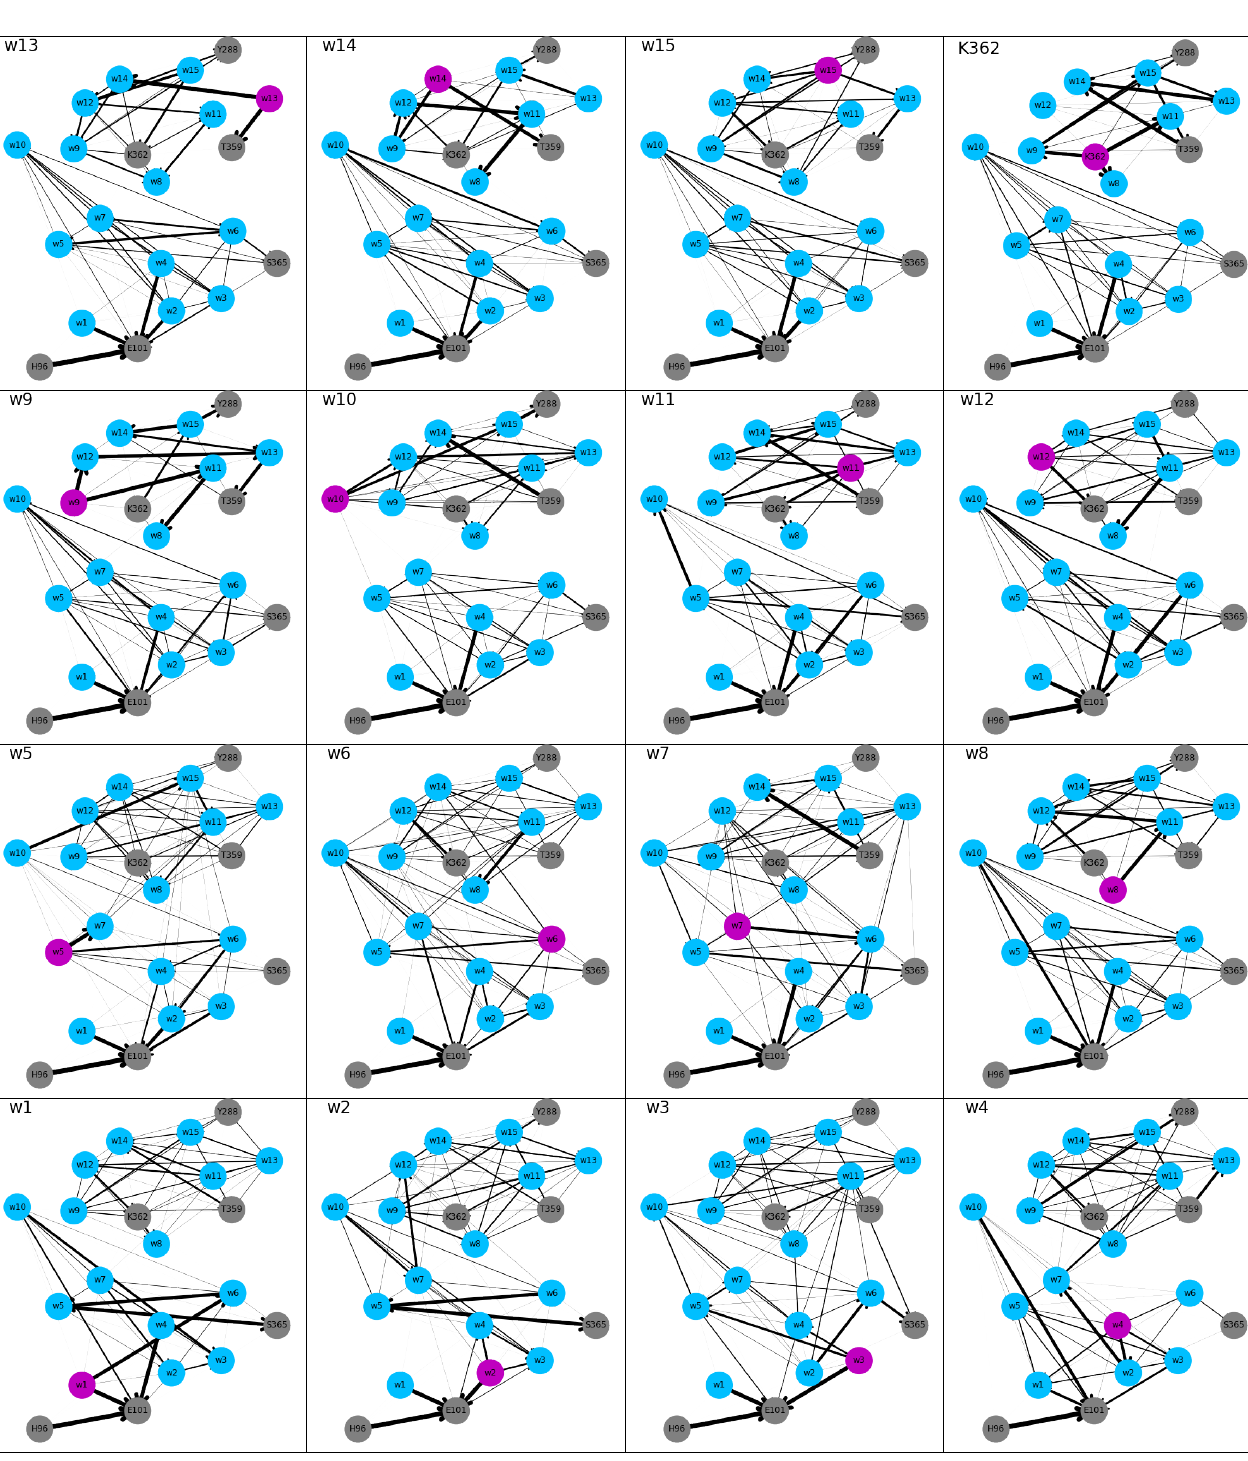
Figure 5. Directed hydrogen-bonded network computed from the MD simulations of “up” models with the excess proton located at different residues. The nodes of the network are the protein residues (in gray) Y288, T359, K362, S365, H96, or E101, and the fifteen water molecules (in blue) in the channel. The residue carrying the excess proton is highlighted in magenta. Edges of the network correspond to hydrogen bonds, shown as arrows pointing from donor to acceptor residue. The thickness of the lines indicate the probability of the hydrogen bonds. Hydrogen-bonded networks of models with protonated H96 and E101, respectively, are shown in Supplementary Figure